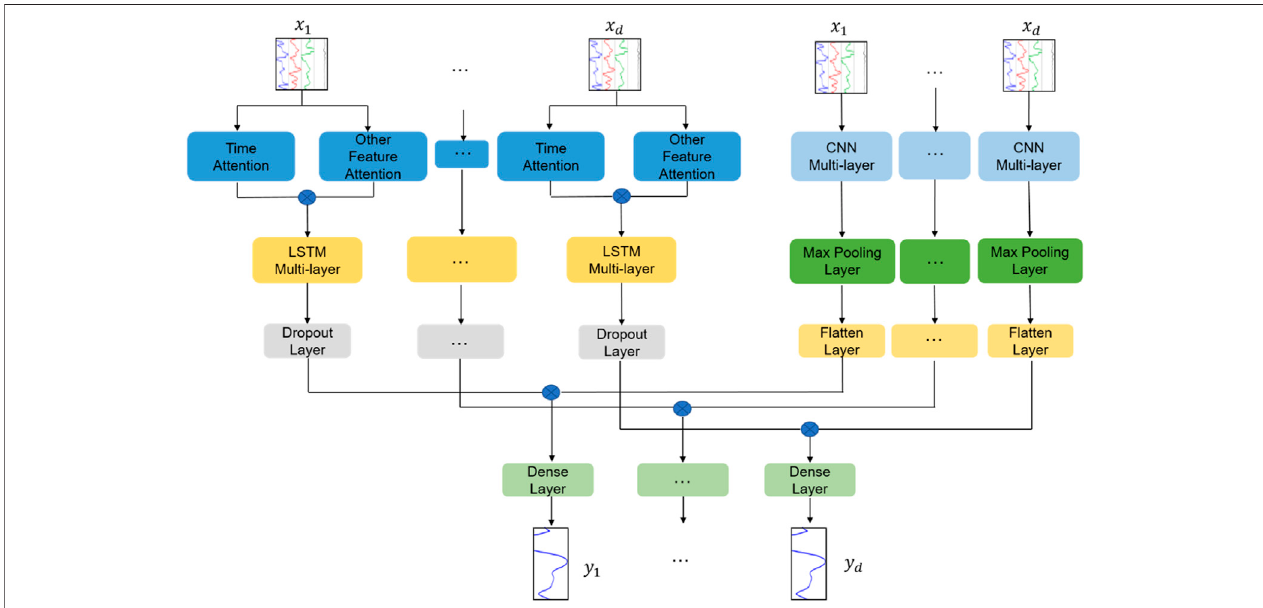
FIGURE 1 | Conceptual overview of the multi-channel CNN-LSTM